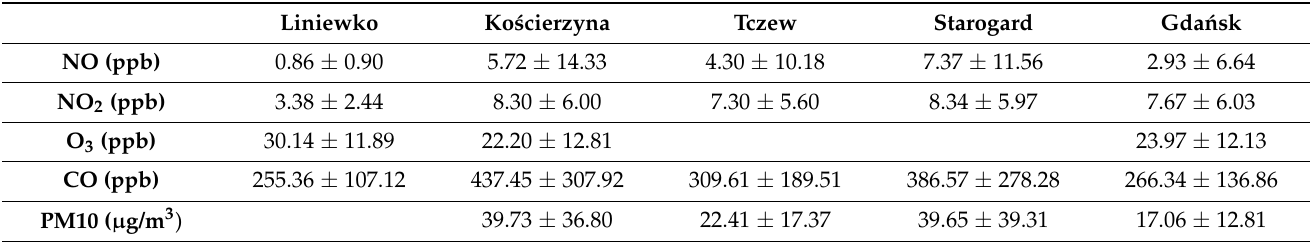
Figure A6. Methane plume modeled by the HYSPLIT model for 1 September 2016, revealed the following values: CH 4 = 2.81 ppm (hourly mean), NMHC = 0.2 ppm, estimated CH 4 emission rate = 120 kg/h. Left and horizontal axis-geographical coordinates, right axis-additional methane concentration above the Stary Wiec background level, i.e., approximately 1.9 ppm. Red circle–well location, black circle-monitoring site. Table A2. Statistics for air pollution data from air quality monitoring stations based on hourly means, collected from January 2012 to July 2015. Mean values for this period, together with standard deviations (1 σ ), are